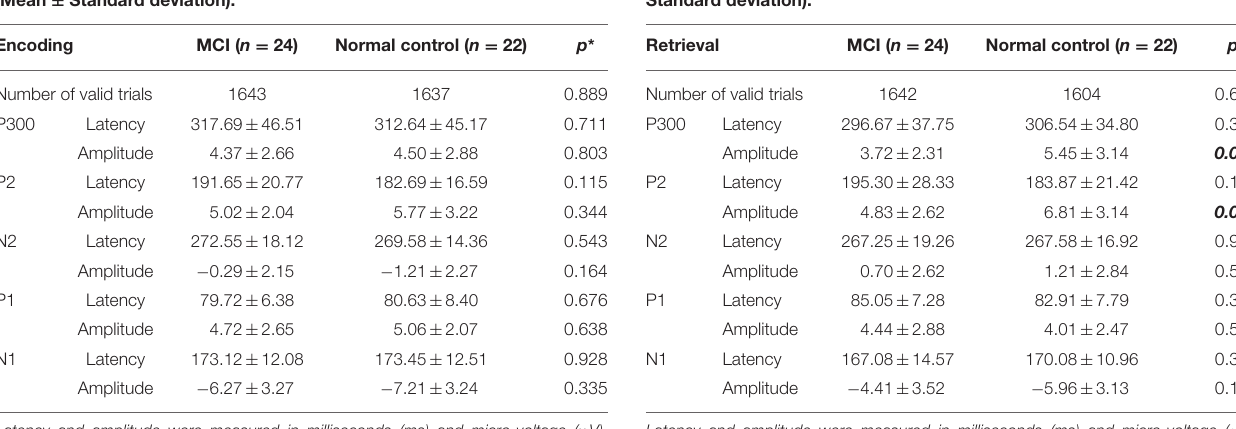
TABLE 3 | Parameters of ERP component in retrieval epoch (Mean ± Standard